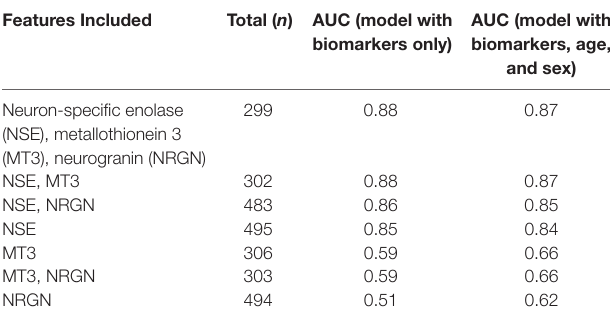
TaBle 2 | Comparison of C-statistics to identify the best performing LR models that differentiate ACRM + mTBI patients from controls using biomarkers alone, or biomarkers with patient age and sex included as covariates.